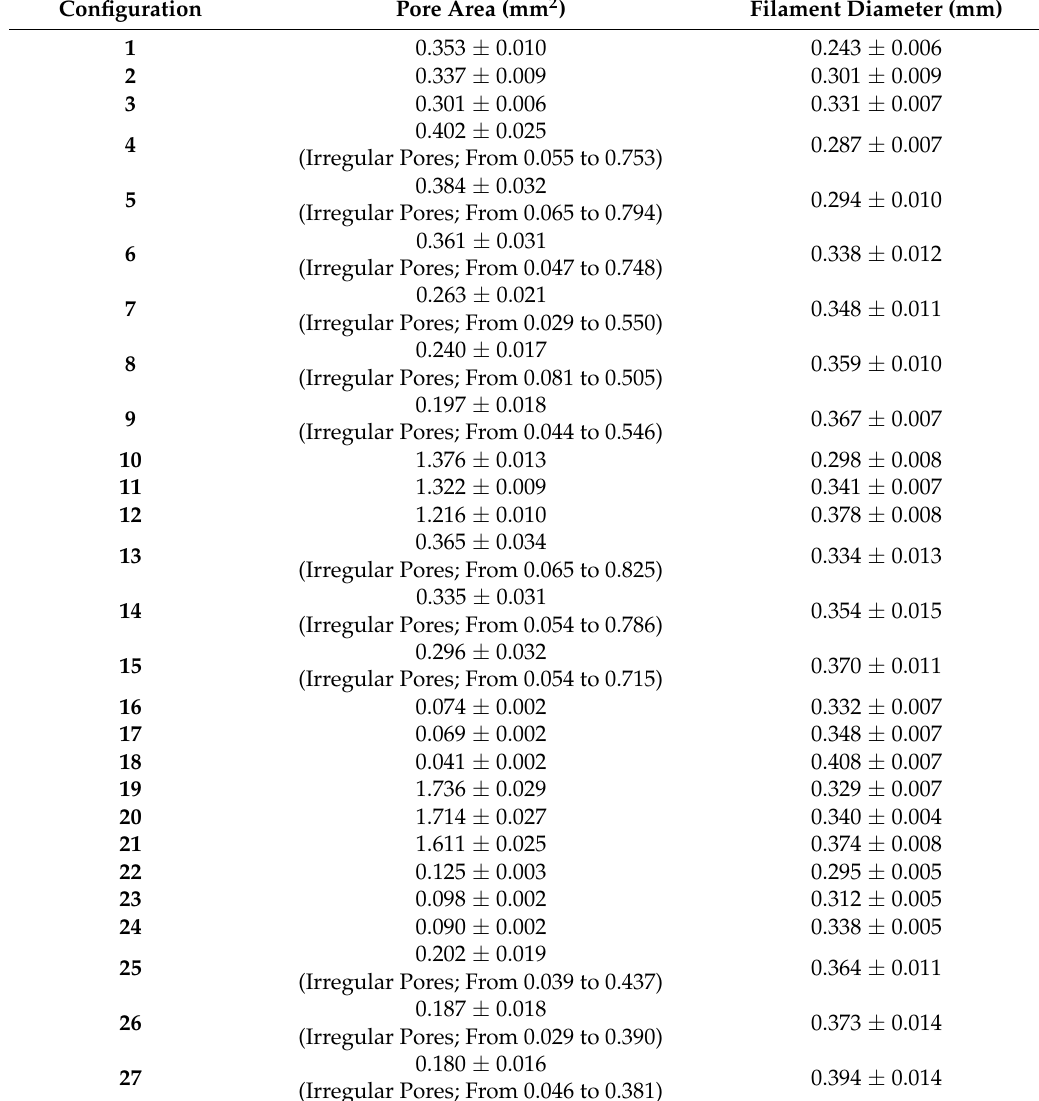
Table 2. Pore area (mm 2 ) and filament diameter (mm) values of each PLA scaffold configuration obtained from scaffold image